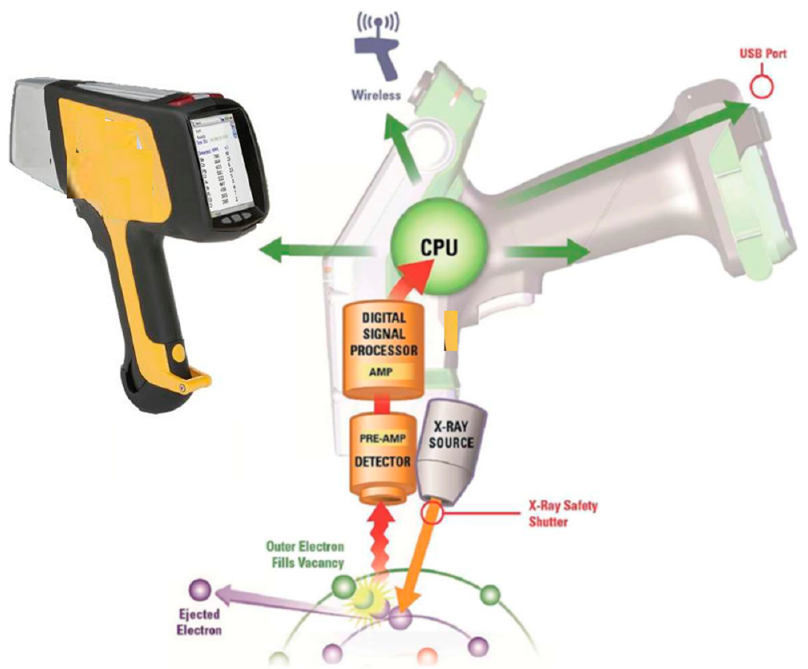
Figure 5. Schematic diagram showing the configuration of a typical handheld XRF analyzer with a commercial unit in the inset, modified from [70].